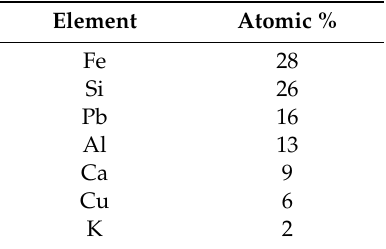
Figure 2. ( a ) Optical microscopy (OM) image of the thin section of sample A, reflected light, dark field. ( b ) Field emission scanning electron microscopy (FESEM) image of sample A and energy dispersive X-ray analysis (EDX) spectra measured on the gold leaf (spot analysis) and on the preparation layer (analyzed area 50 × 50 µm 2 ). The metallic leaf is visible as bright region on the preparation layer. In the preparation layer grains of various materials appear with different levels of grey. Table 1. Elemental analysis of the preparation layer of sample A as determined by EDX. The analysis was performed on an area large enough to represent an average composition.